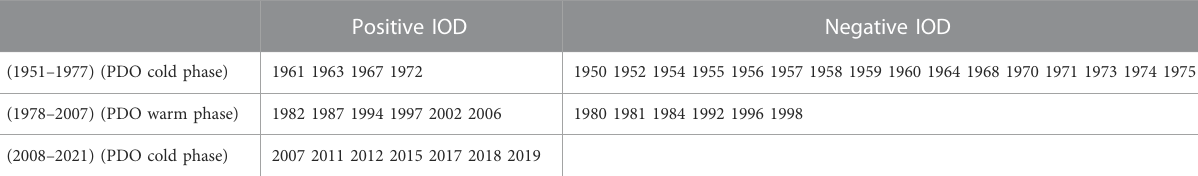
TABLE 1 The positive and negative IOD years of the previous year for P1(1951 – 1977), P2 (1978 – 2007), and P3 (2008 – 2021). Positive IOD Negative